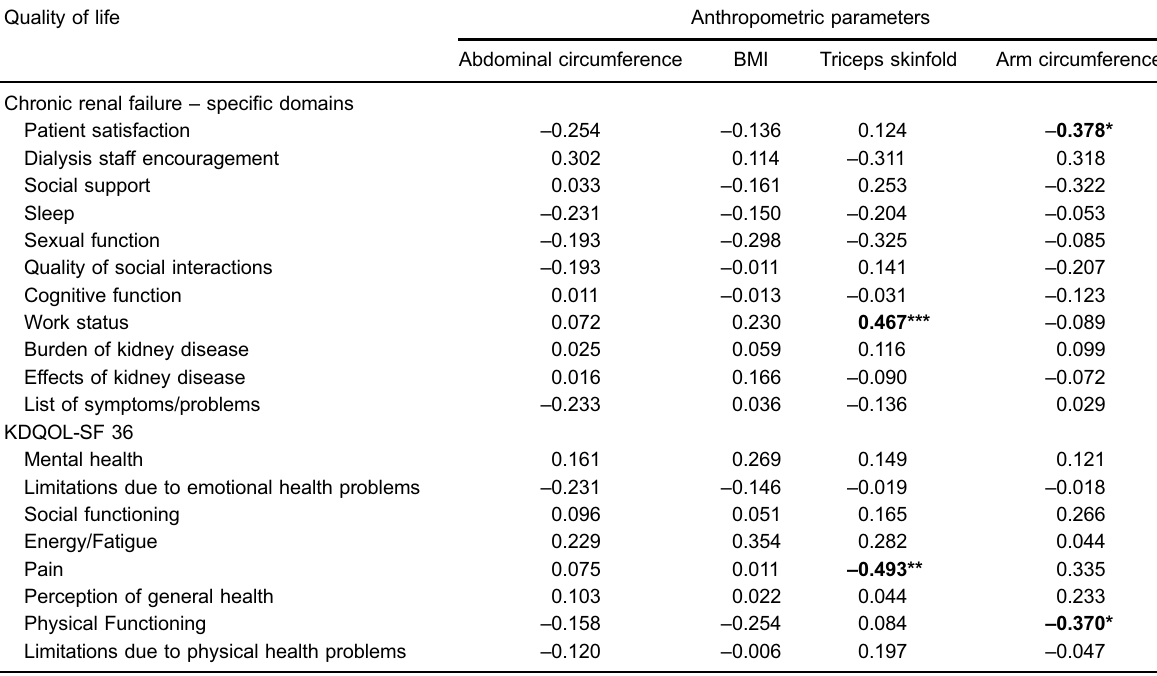
Table 4. Spearman ’ s correlation coef fi cients between quality of life and anthropometric parameters. Quality of